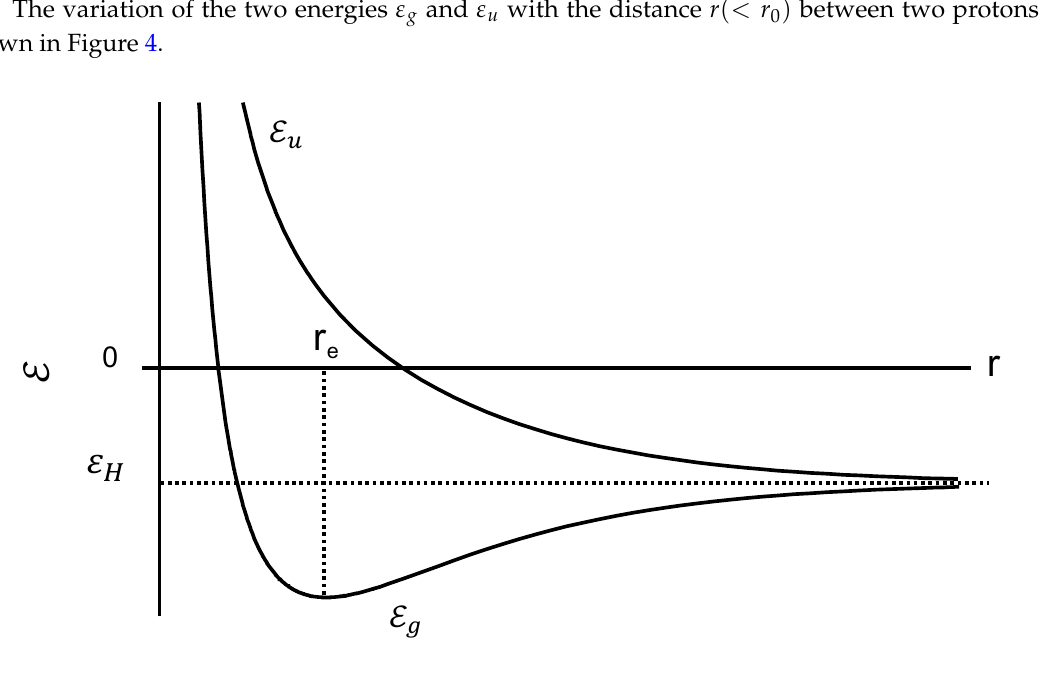
Figure 4. Bonding energy ε g and anti-bonding energy ε u plotted against the interproton